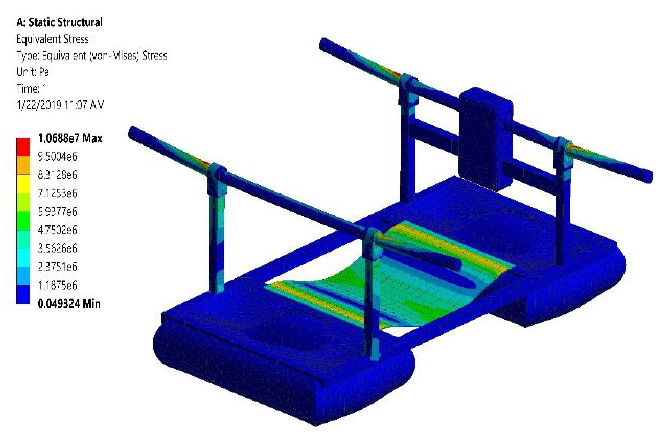
Figure 14. Stress contour of amphibious structure